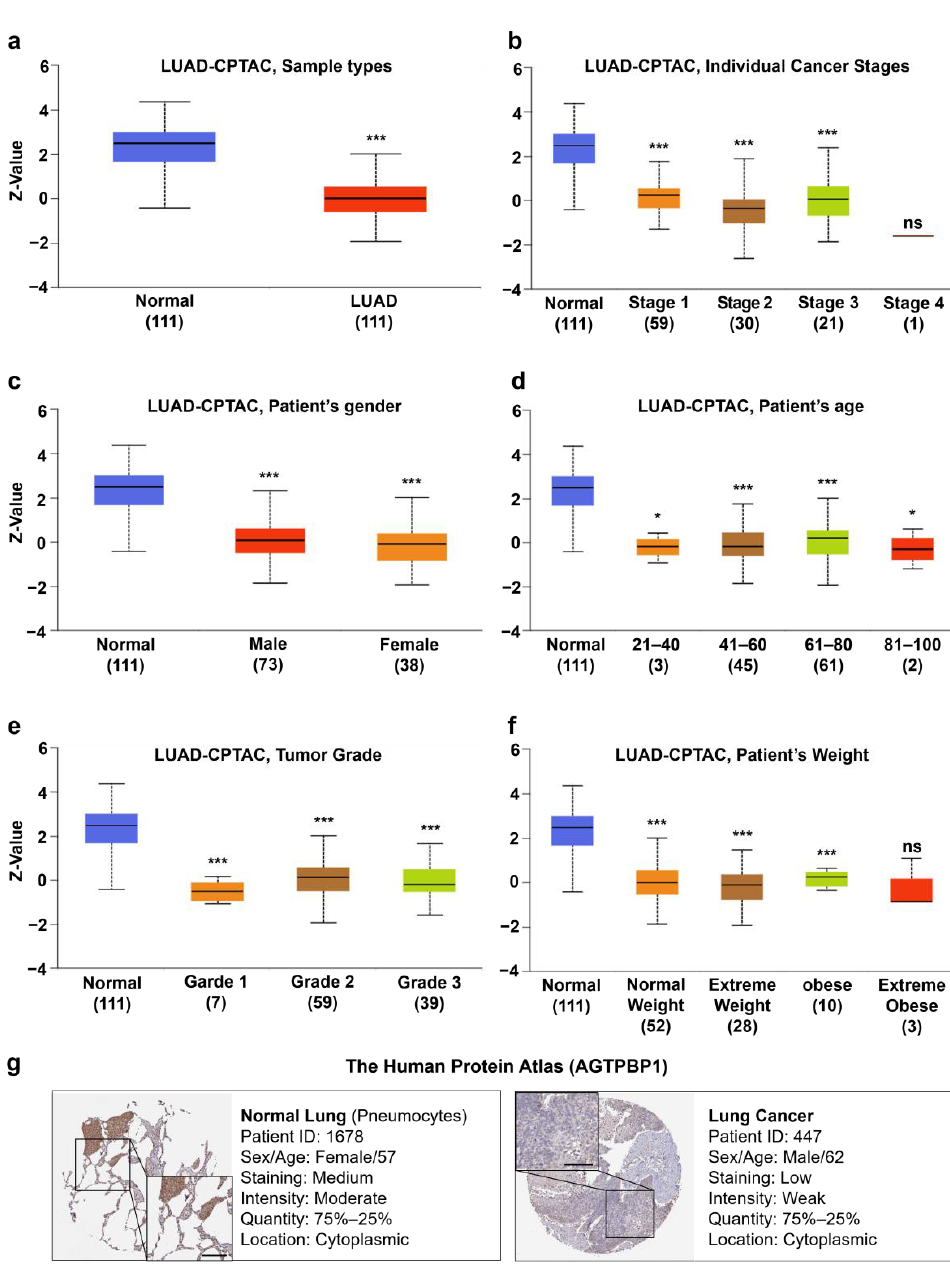
Figure 3. ATP/GTP binding protein 1 ( AGTPBP1 ) protein expression profile in lung cancer tissues and adjacent normal tissues. ( a – f ) Box plot of protein expression level of AGTPBP1 in LUAD (plotted in different colors) and normal lung tissues (plotted in blue) based on characteristics of patients with LUAD was plotted using the UALCAN web tool. The Clinical Proteomic Tumor Analysis Consortium (CPTAC) dataset was categorized as normal versus ( a ) LUAD, ( b ) cancer stage, ( c ) patient’s gender, ( d ) patient’s age, ( e ) tumor grade, and ( f ) patient’s weight. ( g ) Immunohistochemistry data of AGTPBP1 with monoclonal antibody HPA057208 from the Human Protein Atlas (HPA) database. Pneumocytes from normal lung tissue of patient ID 1678 were moderately stained (left panel), whereas lung cancer tissue from patient ID 447 was stained low for AGTPBP1 (right panel). (ns: non-significant; *: p < 0.05; ***: p < 0.001). LUAD, lung